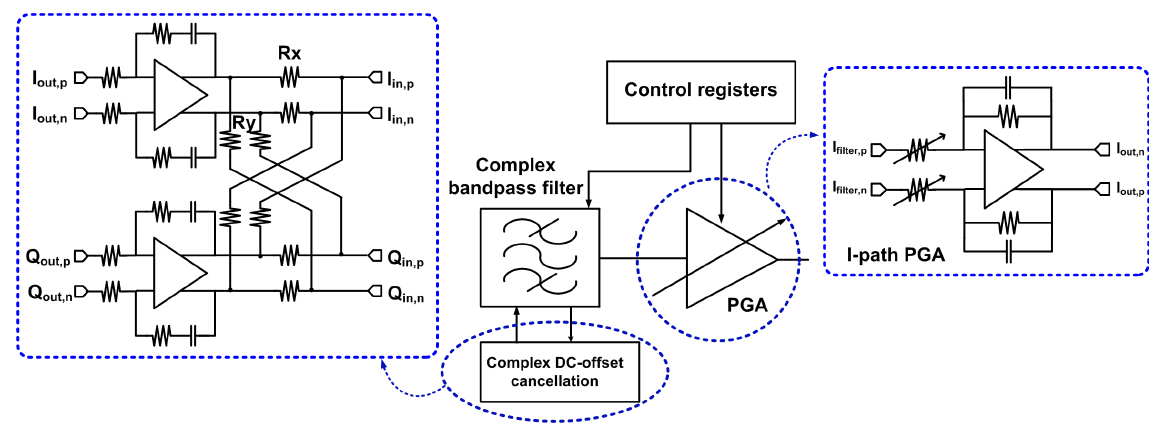
Figure 3. Low-IF Receiver Architecture.